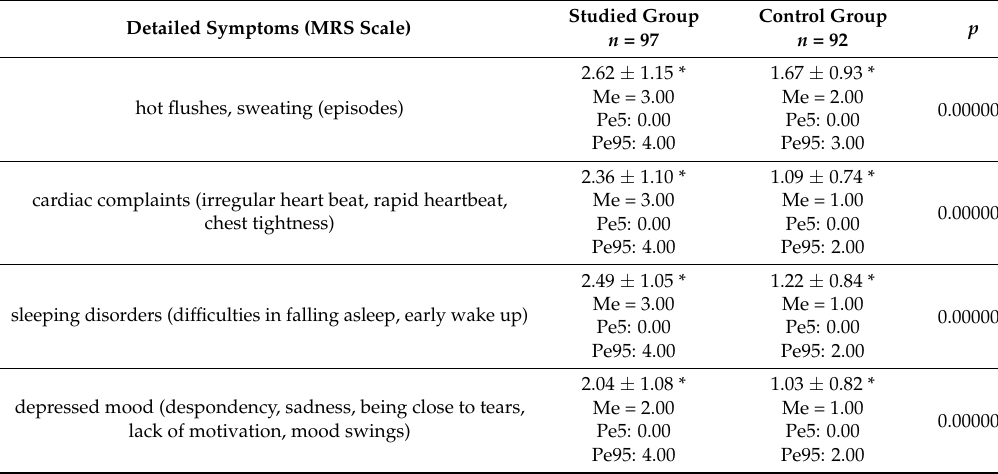
Table 3. The evaluation of the severity of menopause symptoms (MRS scale) in the studied and control groups. (*—statistically